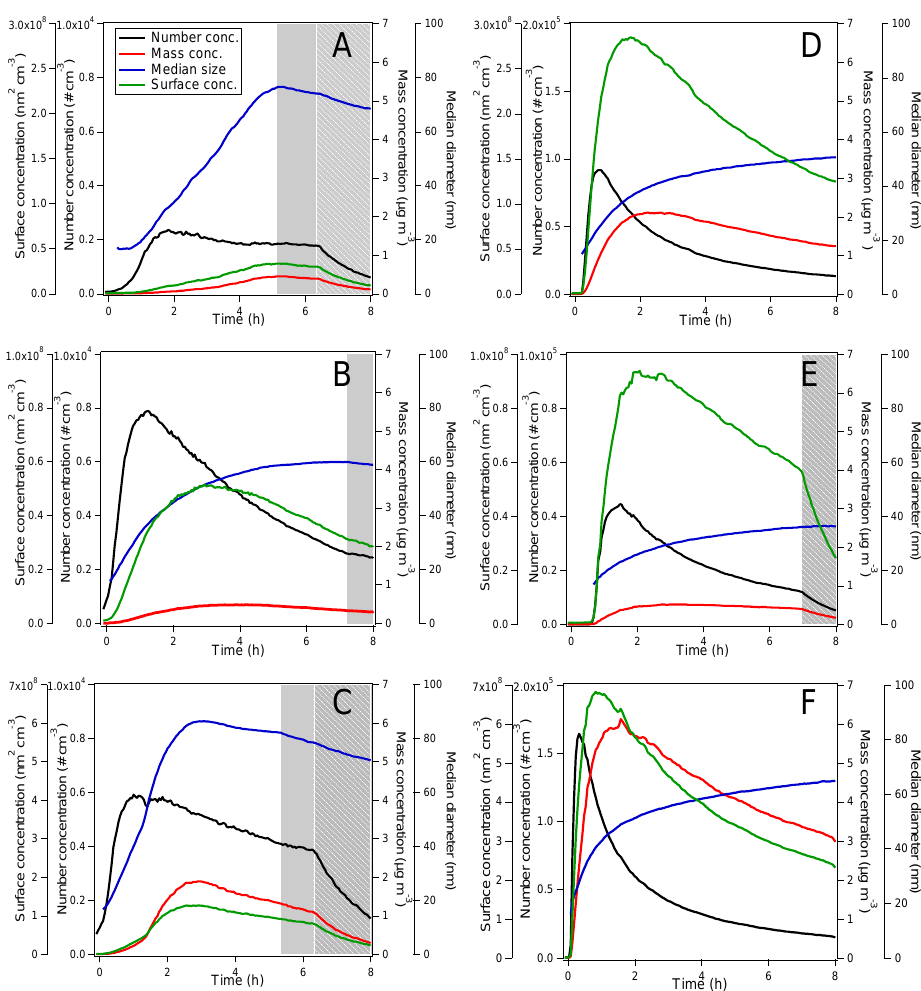
Figure 5. Particle number concentration, mass concentration (not corrected for losses), surface concentration and median diameter of the aerosols from α -pinene (a, d) , β -pinene (b, e) and limonene (c, f) . The left panels are from OH oxidation (the gray shaded area shows the dark period) and right panels from ozonolysis. The gray hatched area corresponds to the flushing out